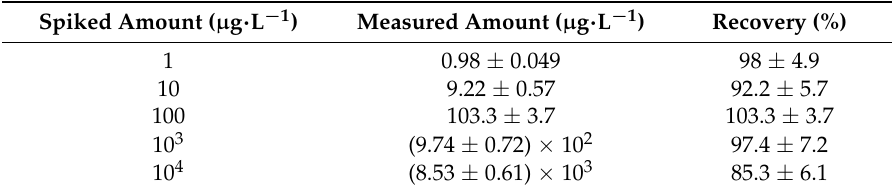
Table 1. Recovery of TC from spiked milk